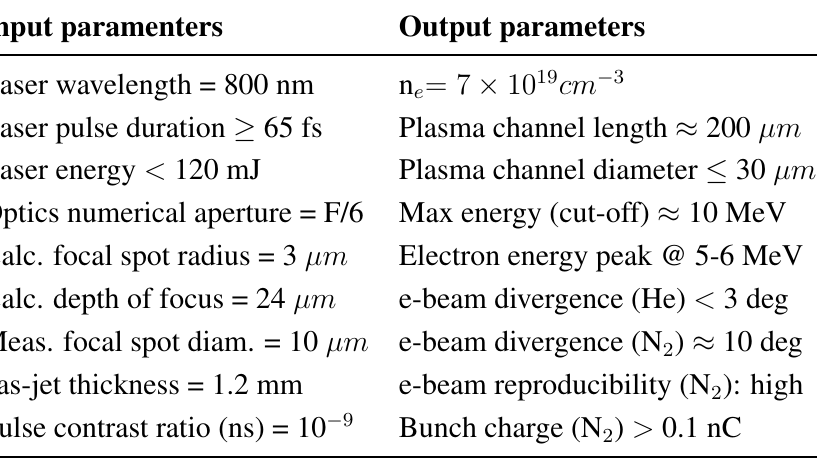
Table 1. List of input and output parameters of the laser-plasma accelerator at